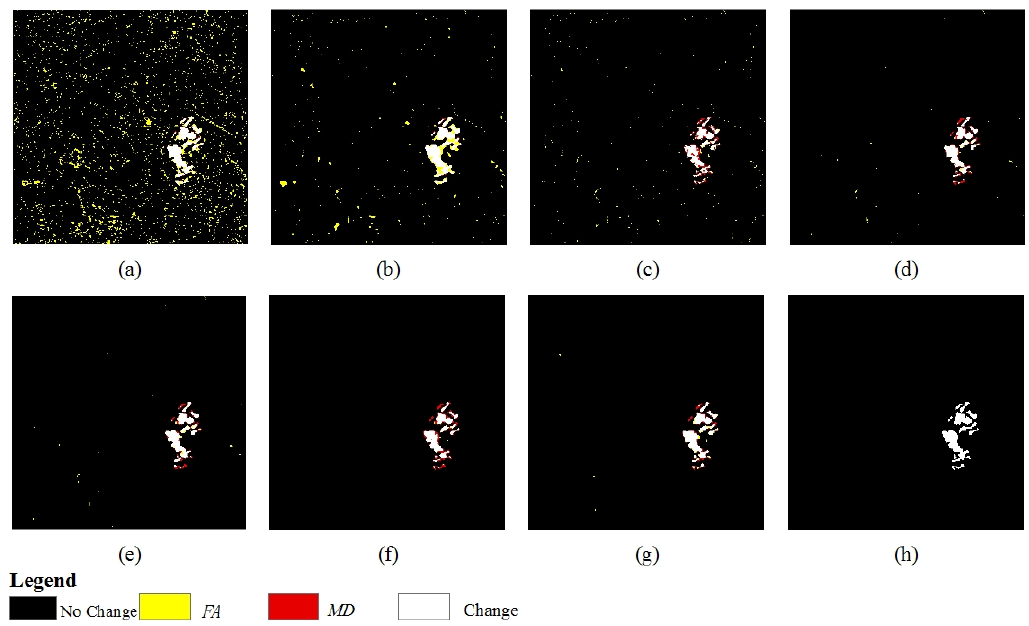
Figure 7. Final change detection maps of the Bern dataset produced by ( a ) EM; ( b ) EMMRF; ( c ) FCM; ( d ) FLICM; ( e ) RFLICM; ( f ) sRSFCM (special case of RSFCM); ( g ) proposed RSFCM; and ( h ) reference image.